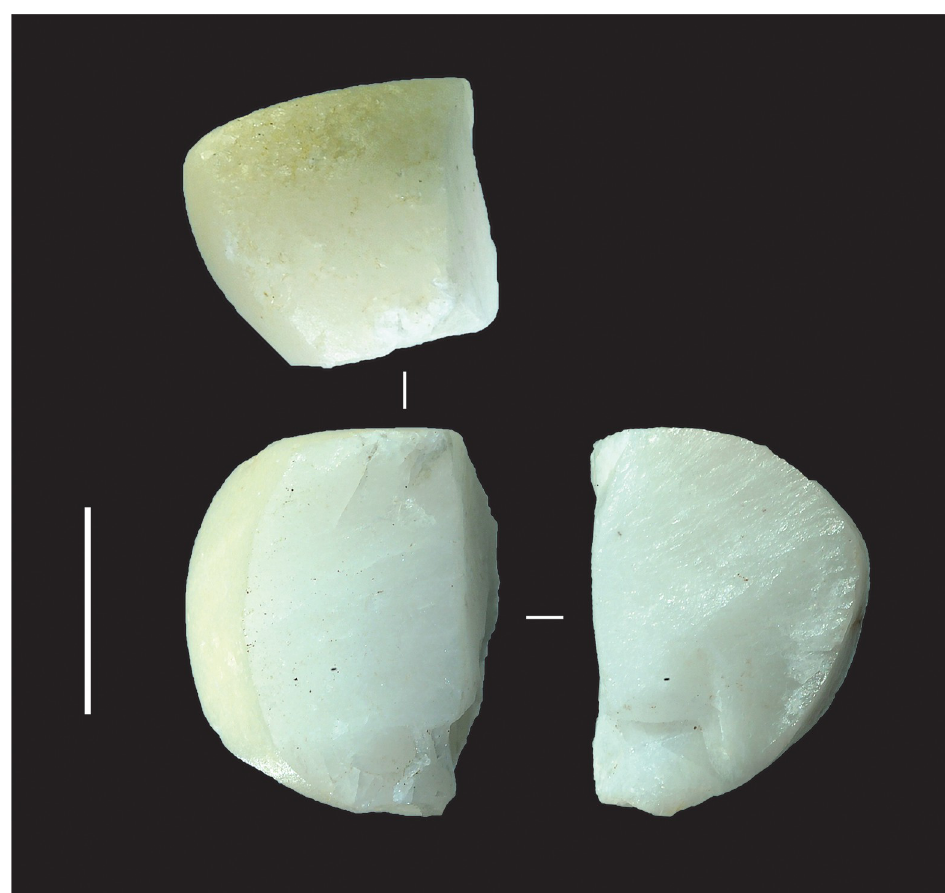
Fig 10. Bipolar core made on a quartz pebble, Horizon IV, Saruq al-Hadid. The artefact is from context 1797. Scale bar 10 mm.